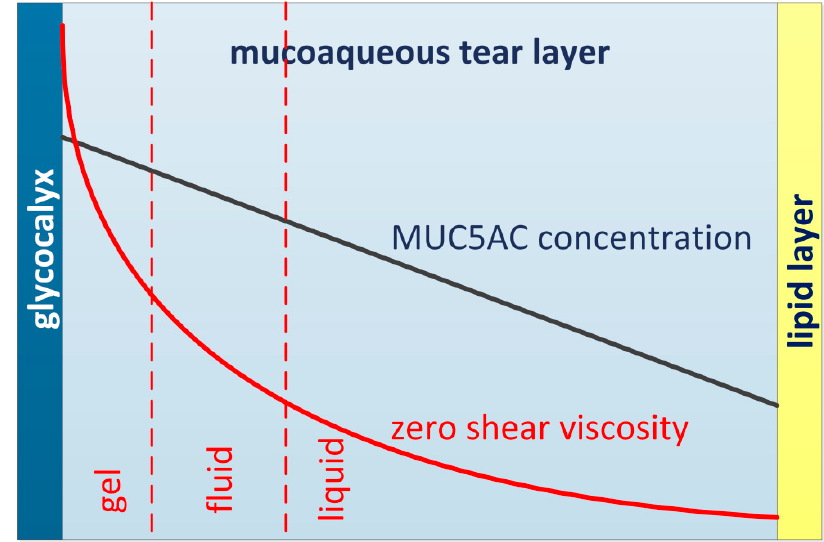
Figure 4. Illustration of the dependence of the zero shear viscosity of the mucoaqueous tear layer from the local MUC5AC concentration.